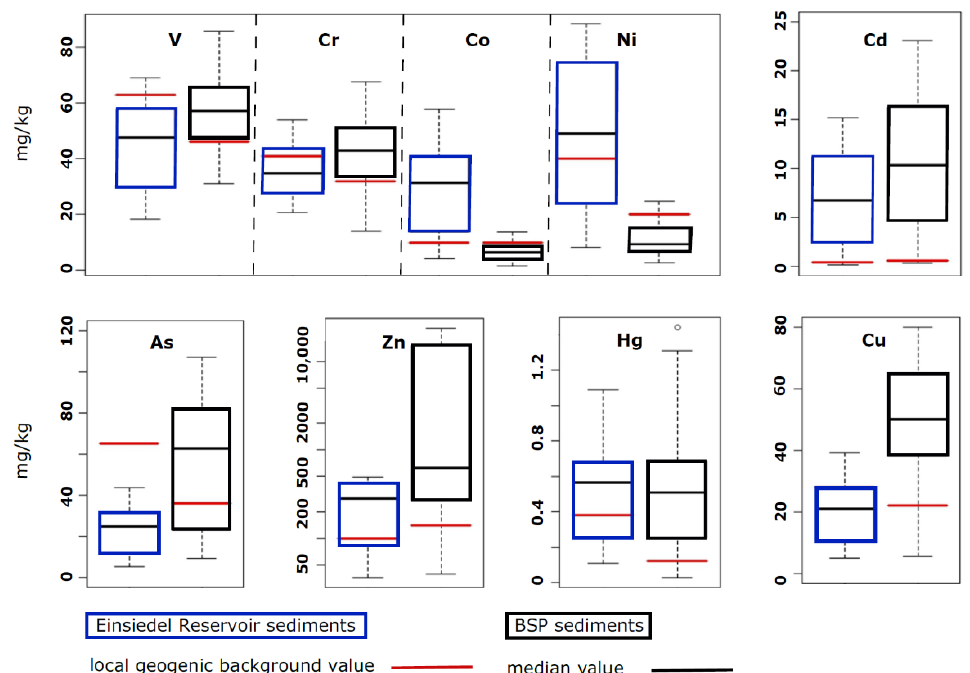
Figure 7. Boxplots of metal(loid) concentrations (mg/kg) in reservoir sediments of the Einsiedel Res-